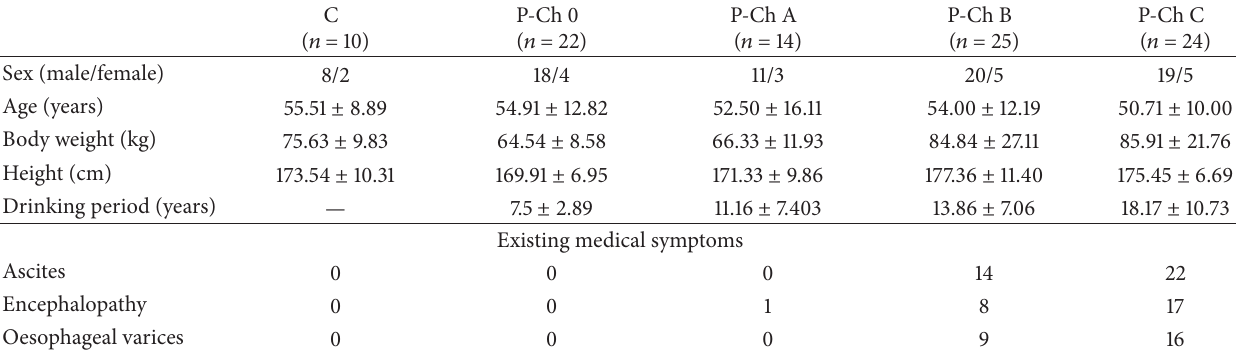
Table 1: Characteristic of alcoholics (P-Ch stages 0, A, B, and C) and healthy controls (C).